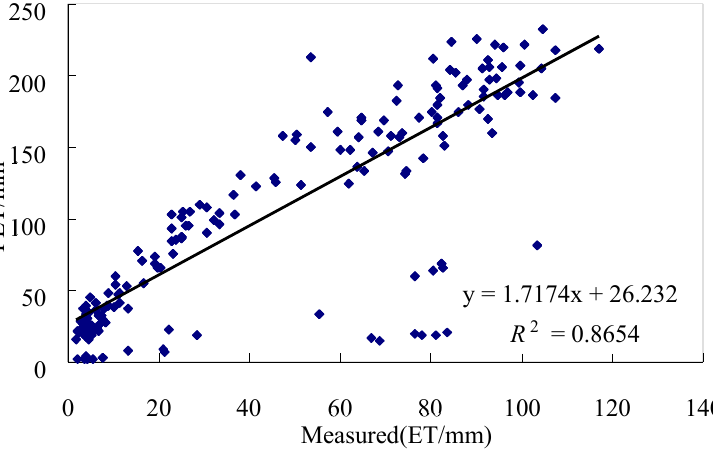
Figure 2. Relationship between GLEAM Ep product and observations evapotranspiration (measured represents observations of evapotranspiration; PET represents GLEAM Ep at meteorological stations.